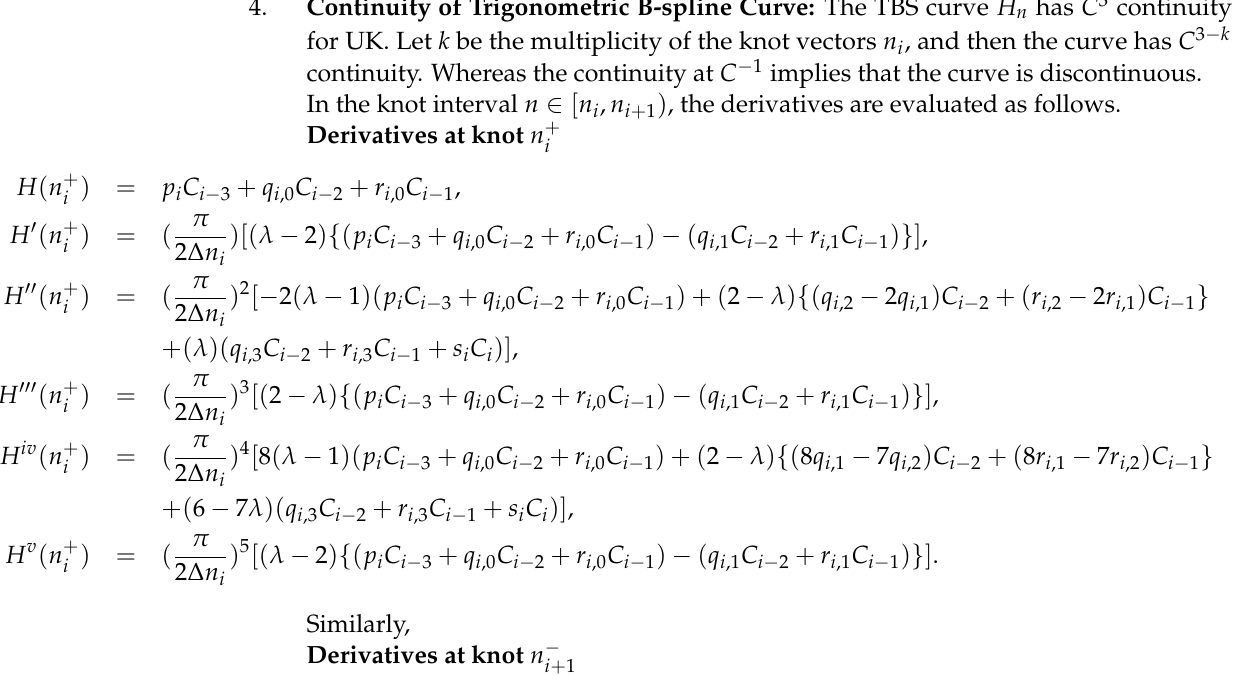
Derivatives at knot n −